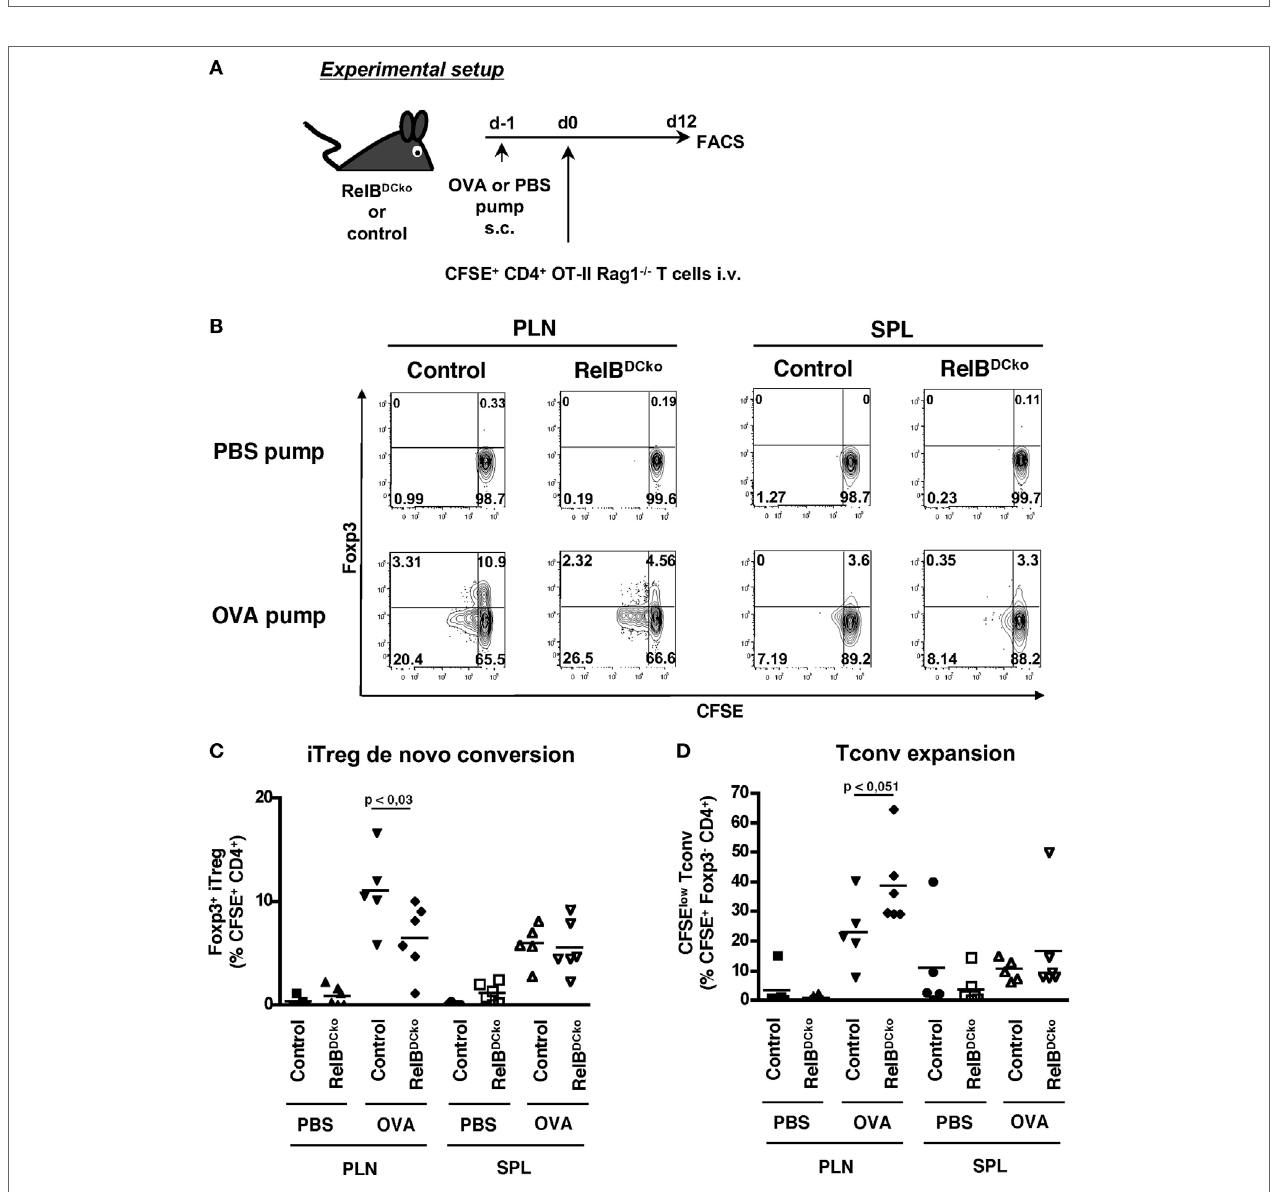
FigUre 3 | RelB DCko mice do not promote enhanced induction of iTregs. (a) Scheme of experimental setup. Micro-osmotic pumps loaded with PBS or OVA peptide were subcutaneously implanted in RelB DCko and control mice. One day later mice received an intravenous injection of 4.5–5 × 10 6 carboxyfluorescein